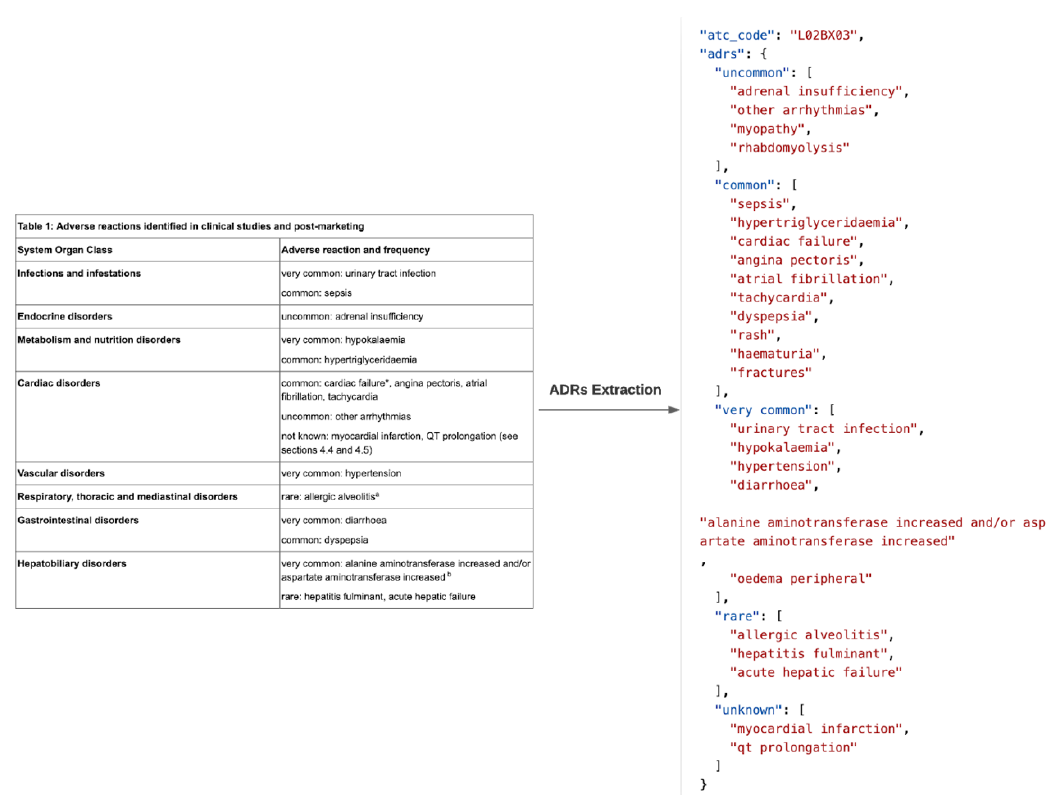
Figure 7. An example of ADR extraction for the tabular text.